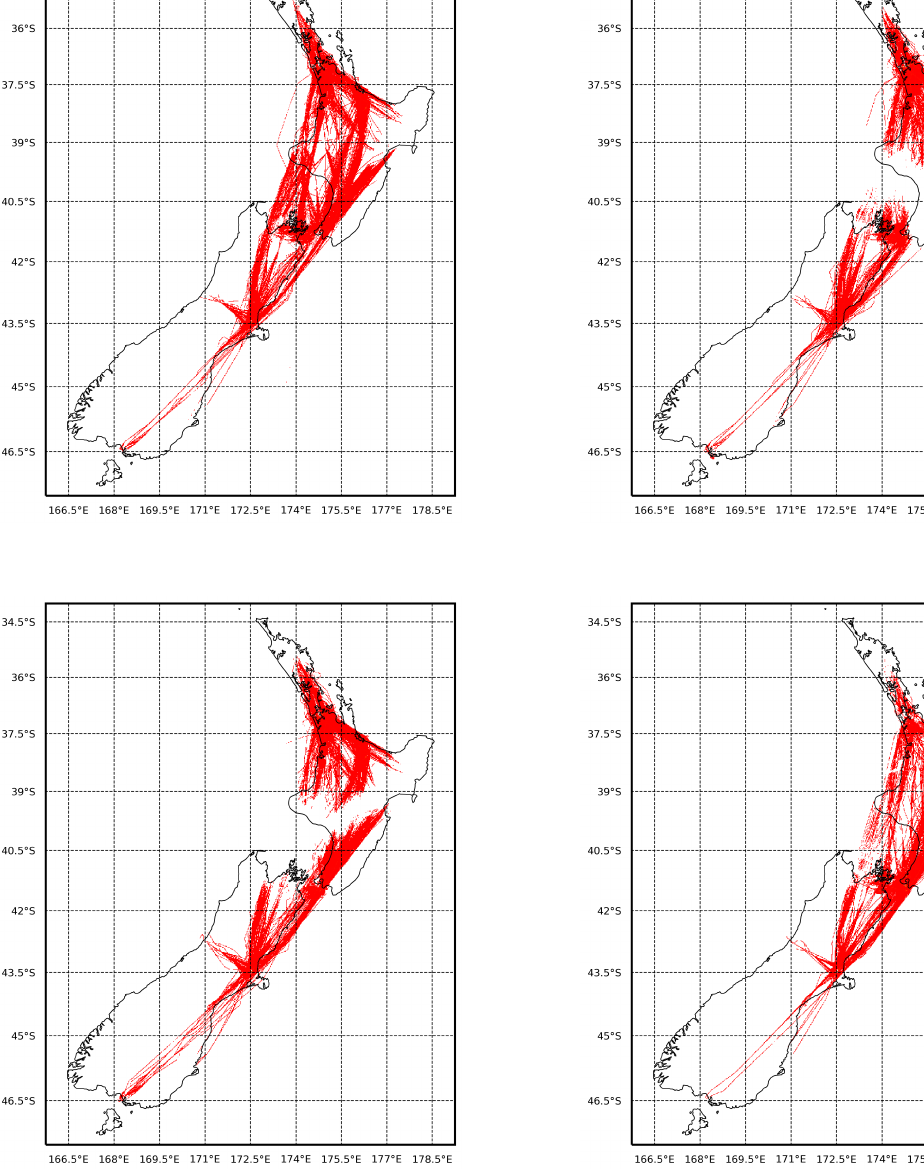
Figure 3. OpenSky Network Q300 data coverage maps over New Zealand during the periods of January 2019 ( top left ), August 2019 ( top right ), December 2019 ( bottom left ), and August 2020 ( bottom right ). We found that the OpenSky network covers the Auckland and Christchurch regions fairly well, but does not quite extend as far eastwards as Gisborne or as far northwards as Kerikeri. Coverage of the South Island seems sufficient to capture the limited quantity of South Island Q300 flights. There also appear to have been temporal coverage gaps over the central North Island during the period of